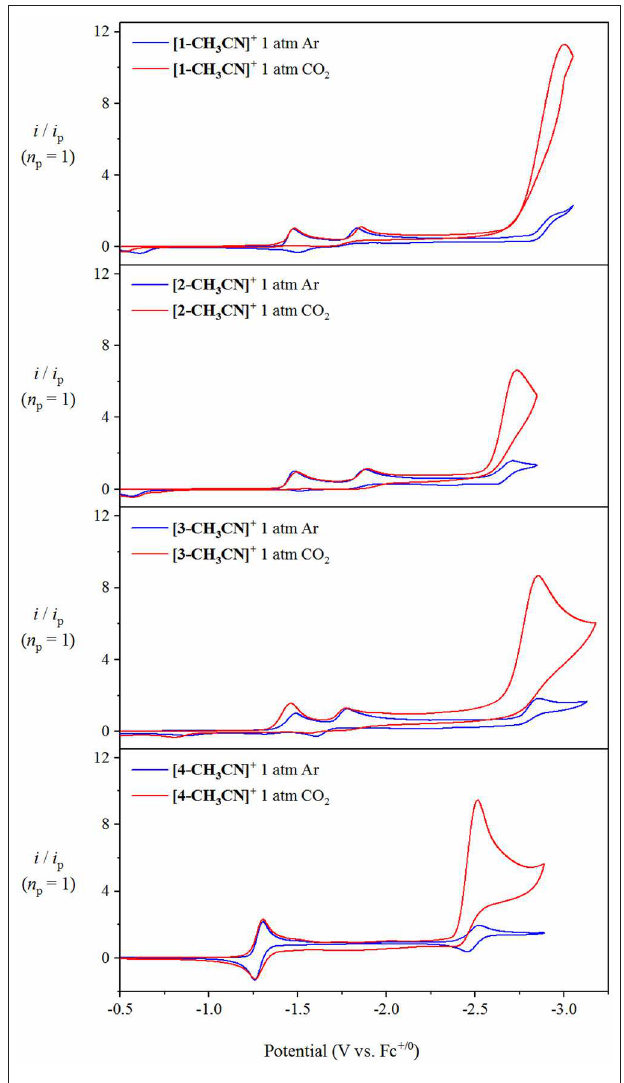
FIGURE 6 | Cyclic voltammograms demonstrating catalytic activity of [1-CH 3 CN] + , [2-CH 3 CN] + , [3-CH 3 CN] + and [4-CH 3 CN] + under 1 atm CO 2 (red) at υ = 0.1V s − 1 with 0.1M [Bu 4 N][PF 6 ] acetonitrile supporting electrolyte containing residual 0.17M (0.3%) H 2 O as a Brønsted acid source. Cyclic voltammograms recorded under 1 atm of argon are also shown (blue). The current (y-axis) data are normalized with respect to the non-catalytic Faradaic response ( i p